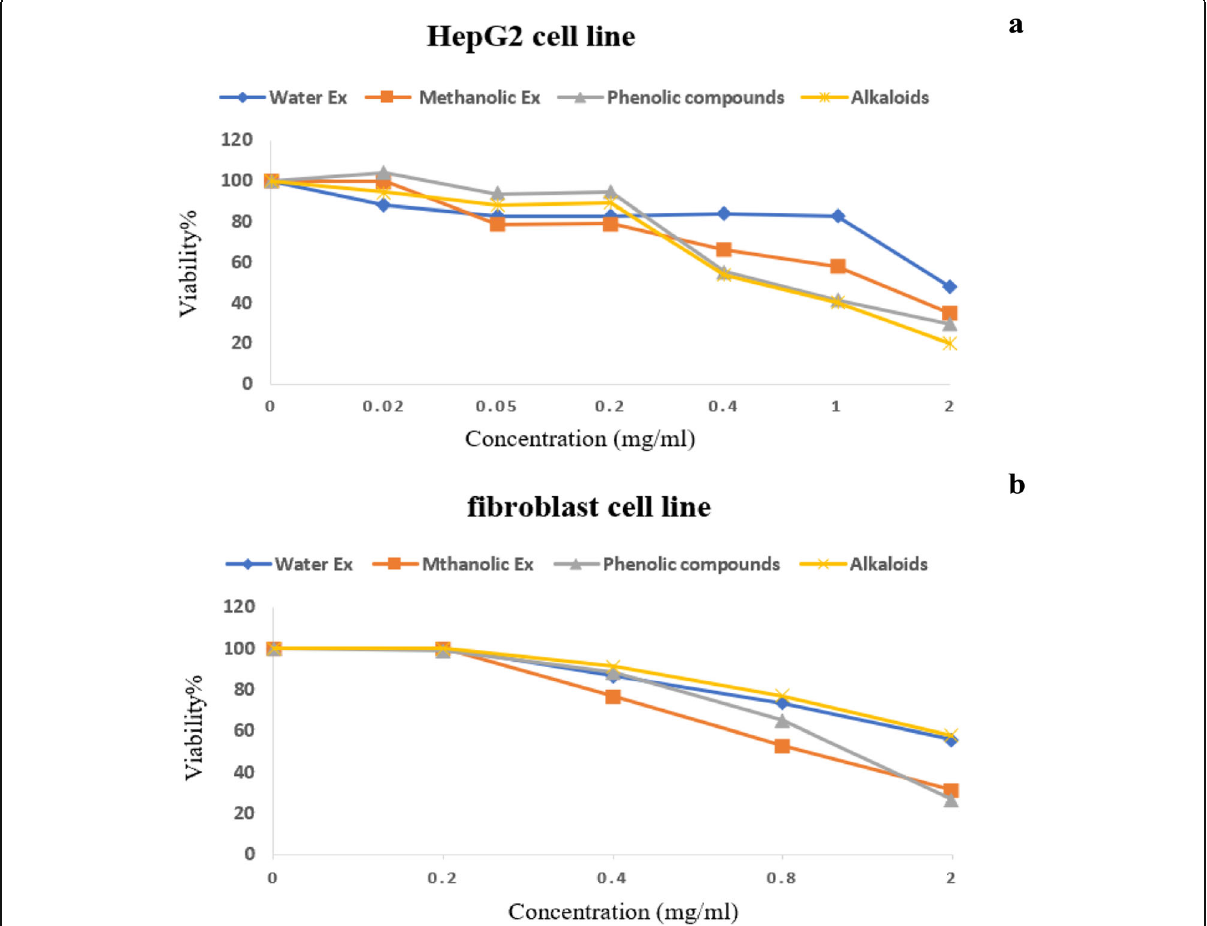
Fig. 4 Evaluation of the cellular viability with different concentrations of phenolic compounds, alkaloids, and aqueous and methanolic extracts of S. platensis on HepG2 cells ( a ) and fibroblast cells ( b ) after 24 h incubation. Values are mean ± SD ( n = 3)